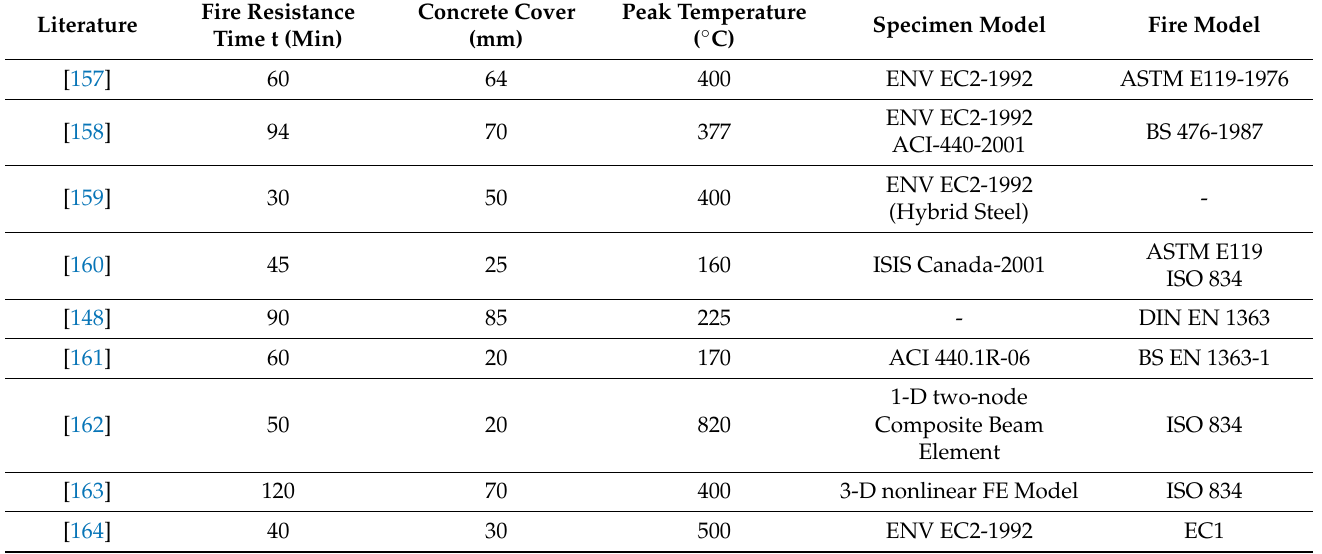
Table 4. Overview of FE and Experimental